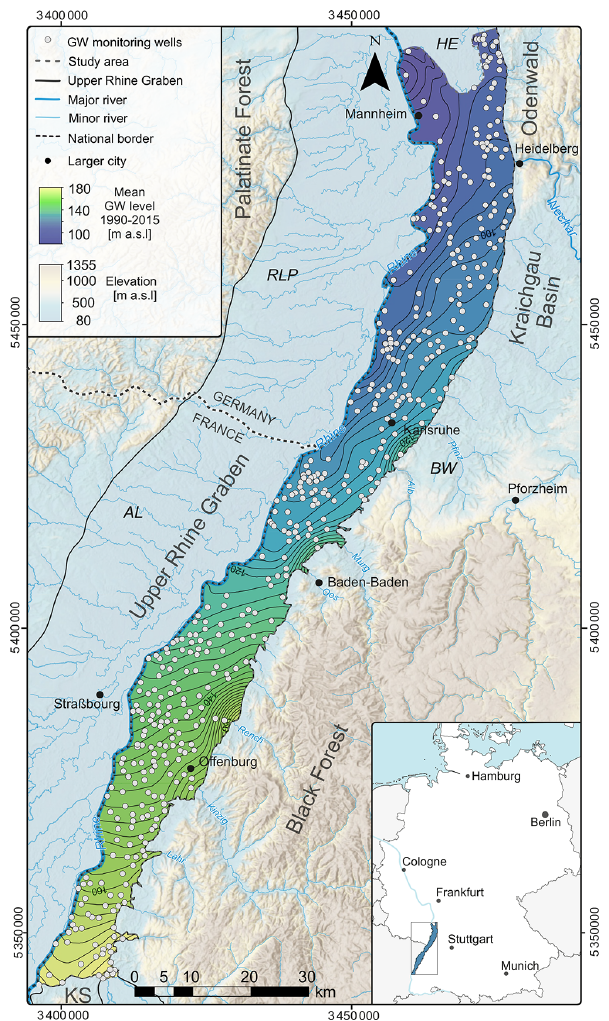
Figure 1. Study area within the URG and the 480 groundwater mon- itoring wells used for optimization. RLP – Rhineland-Palatinate; He – Hesse; BW – Baden-Württemberg; Al – Alsace (France); KS – Kaiserstuhl volcanic